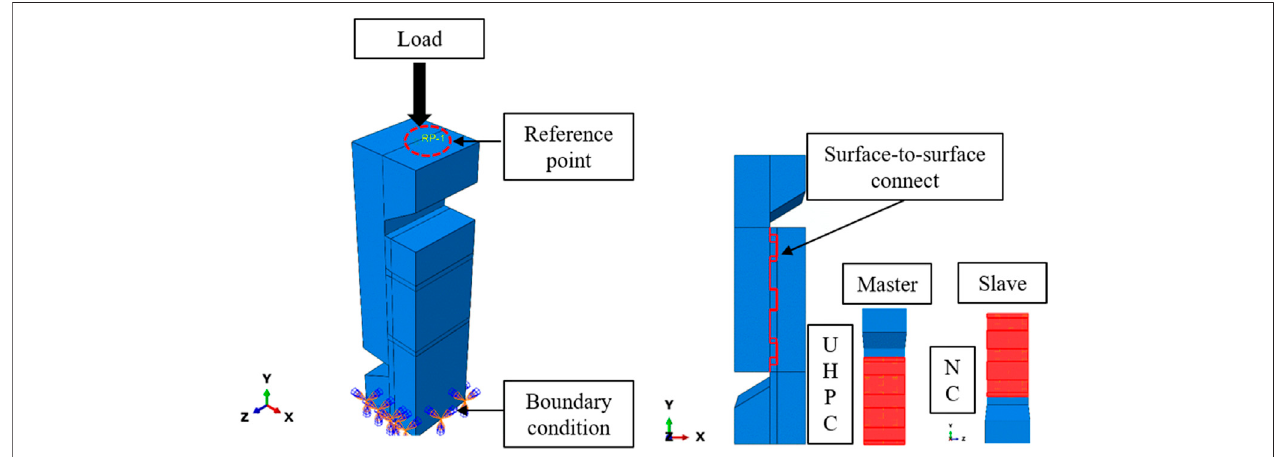
FIGURE 4 | Boundary conditions and